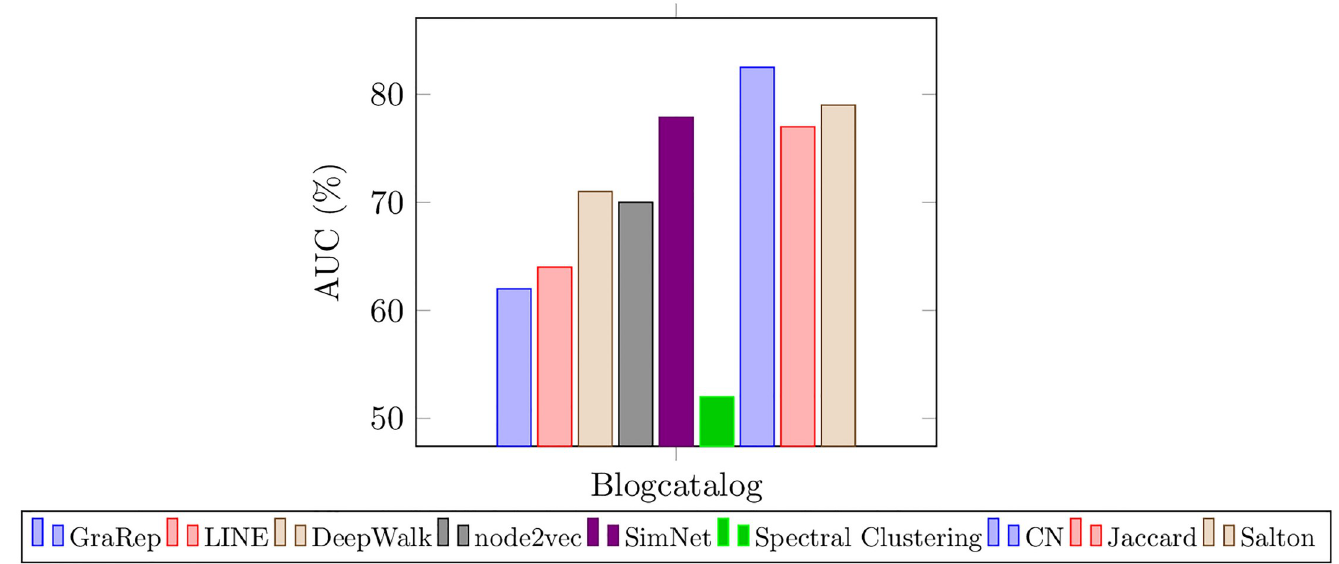
Fig 3. Experimental results on link